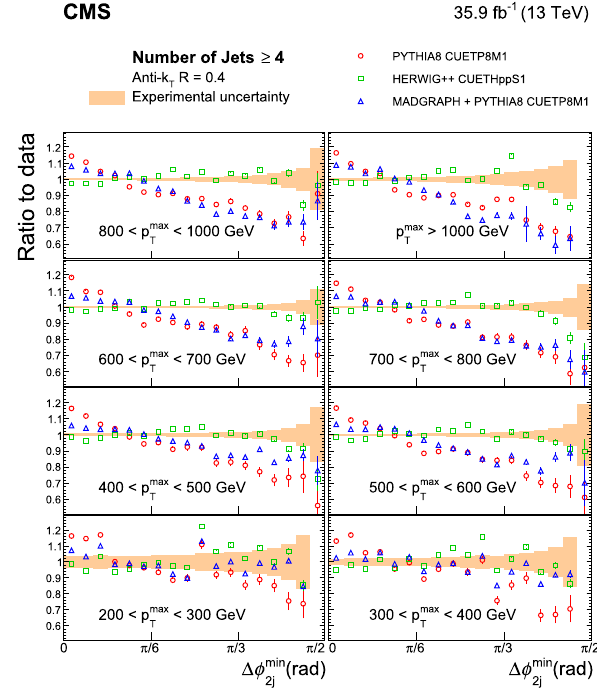
Fig. 12 Ratios of pythia 8, herwig++ , and MadGraph + pythia 8 predictions to the normalized inclusive 3-jet cross section differential in Δφ min , for all p max regions. The solid band indicates the total exper- 2j T imental uncertainty and the vertical bars on the points represent the statistical uncertainties in the simulated data